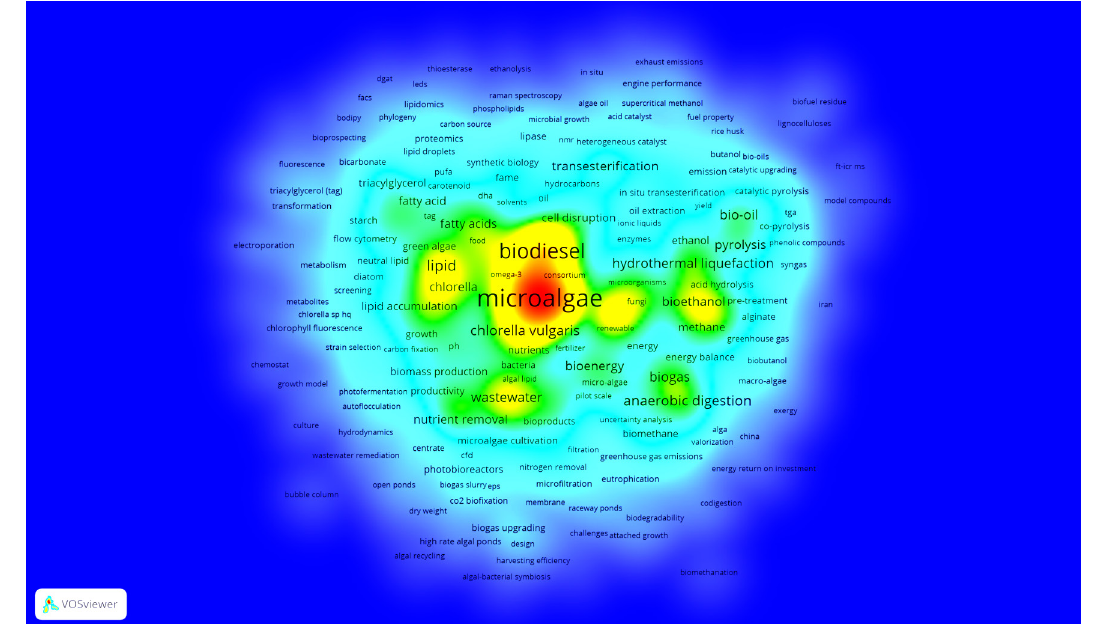
Figure 7. Density view of the keywords with a frequency over 5 times created by